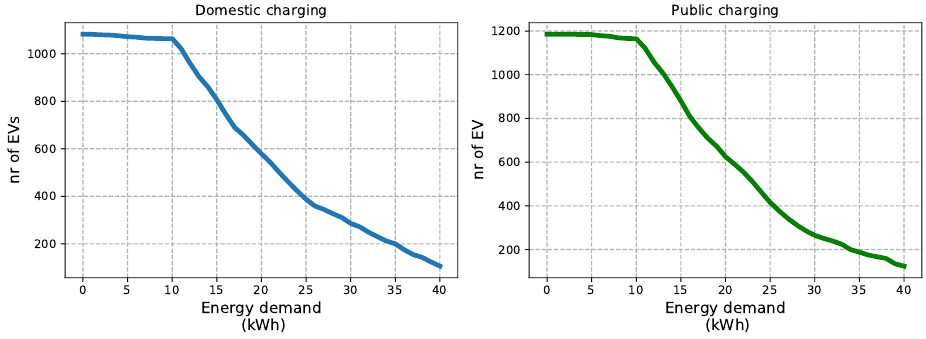
Figure 8. Duration curves of energy demand for domestic and public charging in Scenario